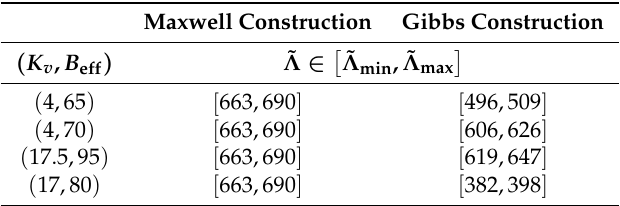
Table 1. The effective tidal deformability ˜ Λ for a given hybrid equation of state model over the mass-ratio [ 0.73,1.00 ] . The parameter pairings in the leftmost column denote the vBag parameters for the range q ∈ quark model that the DBHF model transitions into. For reference, the purely nuclear DBHF model yields [ 663,690 ] . The effective tidal deformability ˜ Λ and mass ratio q are dimensionless. values of ˜ Λ ∈